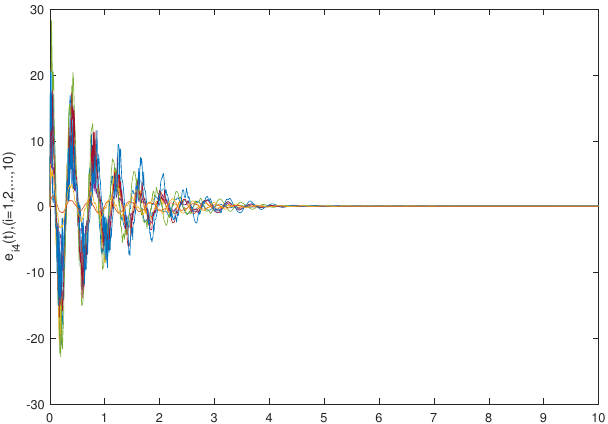
Figure 8. Synchronization errors e i 4 ( i = 1,2, · · · ,10 ) of the fractional-order system (32) and (33) with the controllers.